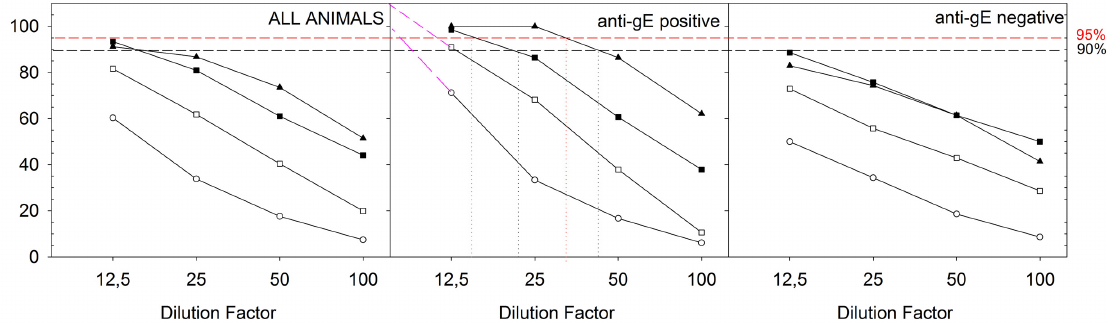
Fig 4. ELISA tests sensitivity comparison. Sensitivity as a function of milk dilution using the (o) classic test, ( ▲ ) ANANAS integrated, ( □ ) Commercial with 0.25 S/P threshold, ( & ) commercial with 0.1 S/P threshold methods. Data have been elaborated taking into consideration all animals (left panel) or separating the results of anti-gE positive (mid panel)/negative (right panel) animals. The dashed parts of the curves in mid panel were generated by linear extrapolations from the two closest data points. The vertical dotted lines highlight the interception of dilution curves with the 95/90% sensitivity. These data are also reported in table format in (S3